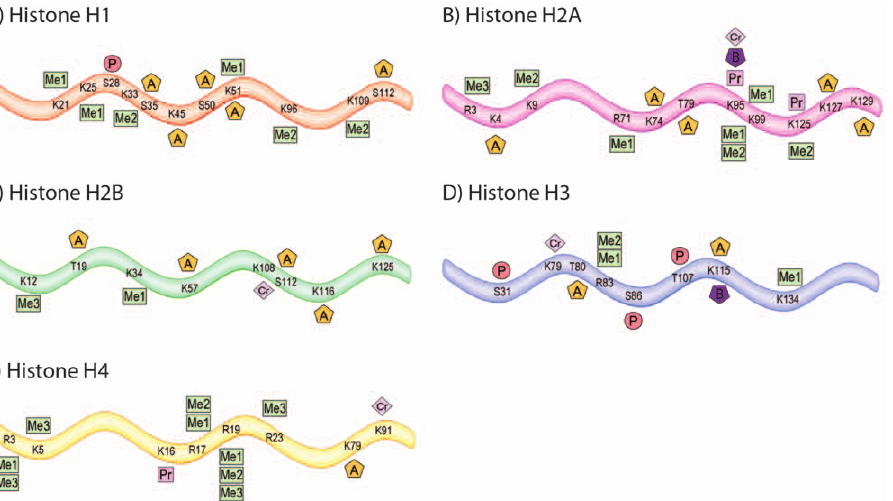
Figure 6. All novel histone PTMs. Summary of all novel PTMs identified on H1 ( A ), H2A ( B ), H2B ( C ), H3 ( D ) and H4 ( E ). Sites of PTMs are indicated by A for acetylation, B for butyrylation, Cr for crotonylation, Me1, Me2 and Me3 for mono-, di- and trimethylation, P for phosphorylation and Pr for propionylation. Residues are numbered starting with the first residue after the cleaved methionine. Canonical H1, H2A, H2B and H3 histones are shown which represent sequences common across all subtypes.